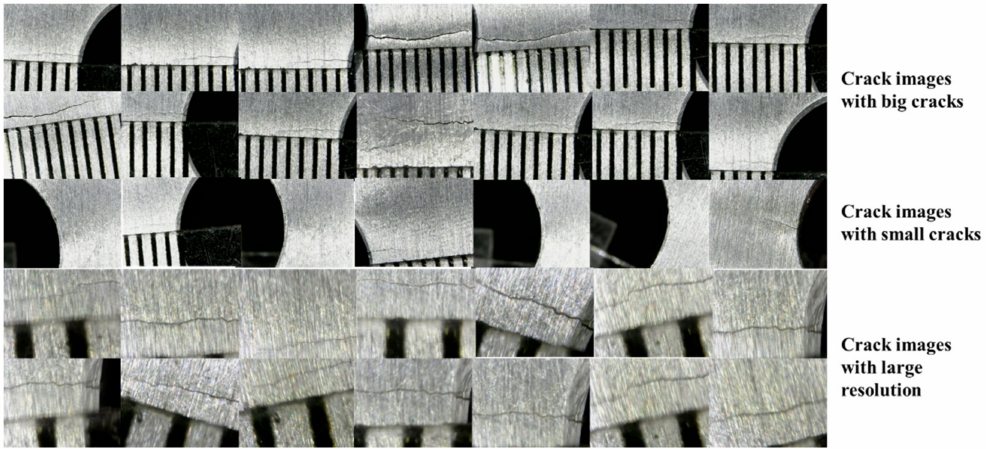
Figure 11. Examples of images used for training